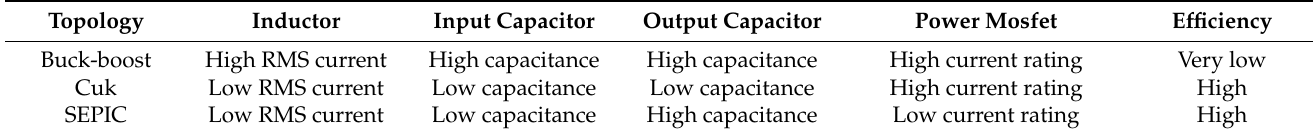
Table 2. Characteristics of different DC–DC converter topologies. Source [11], own elaboration.